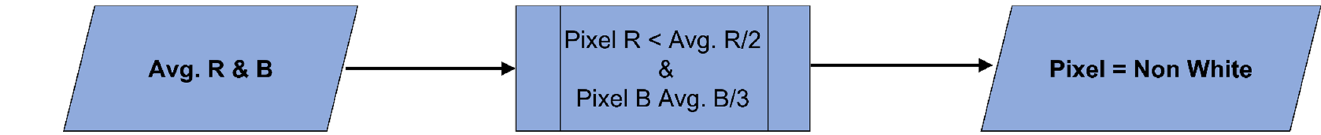
Figure 4. Workflow of step 2. Elimination of dark pixels.